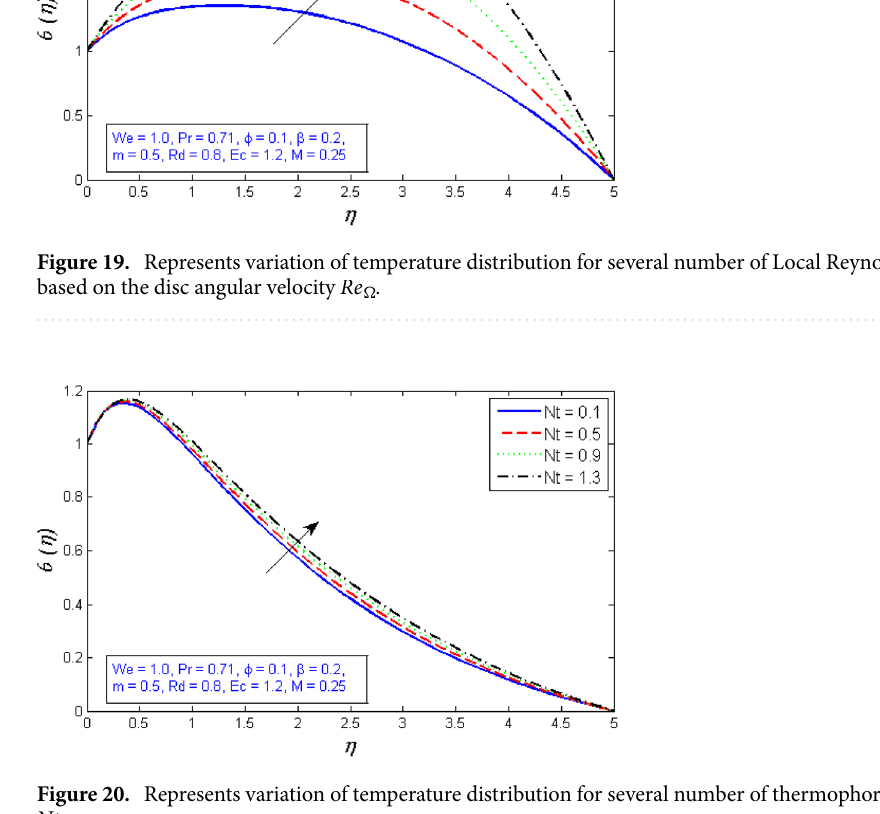
Figure 20. Represents variation of temperature distribution for several number of thermophoresis parameter Nt .